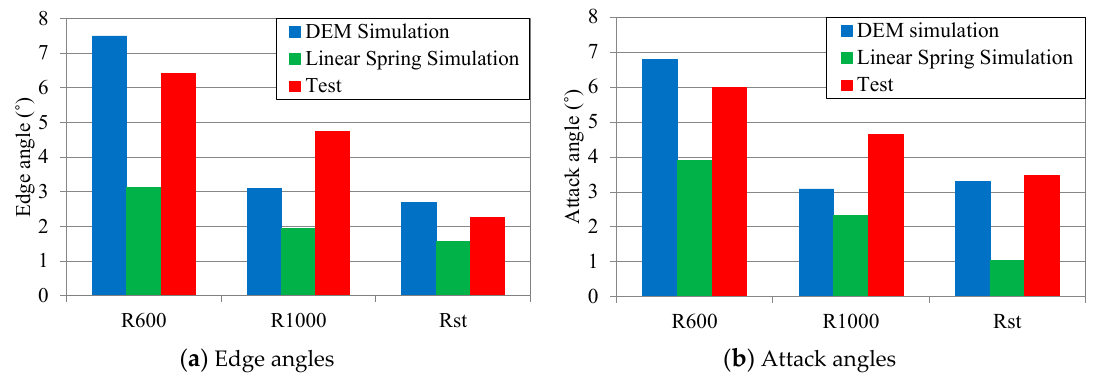
Figure 10. Edge angles and attack angles in the experiment and the